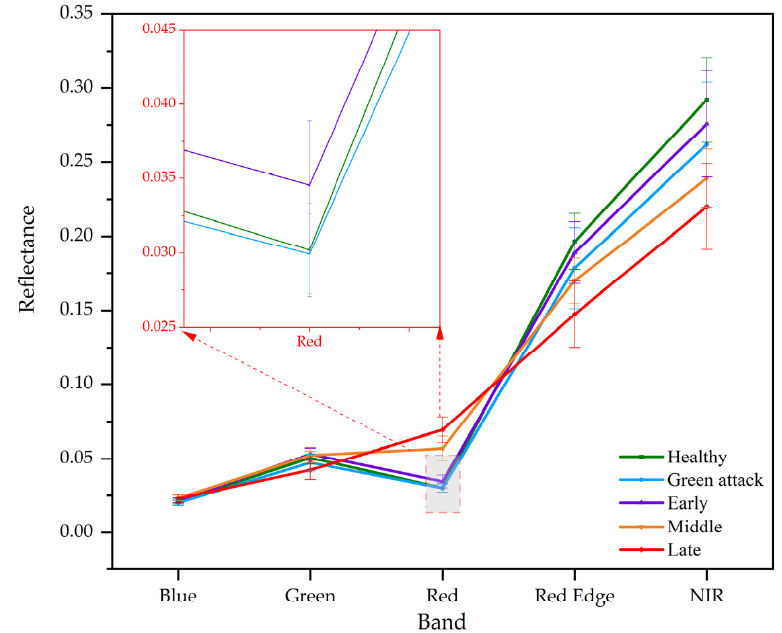
Figure 8. Canopy spectral reflectance at each infection